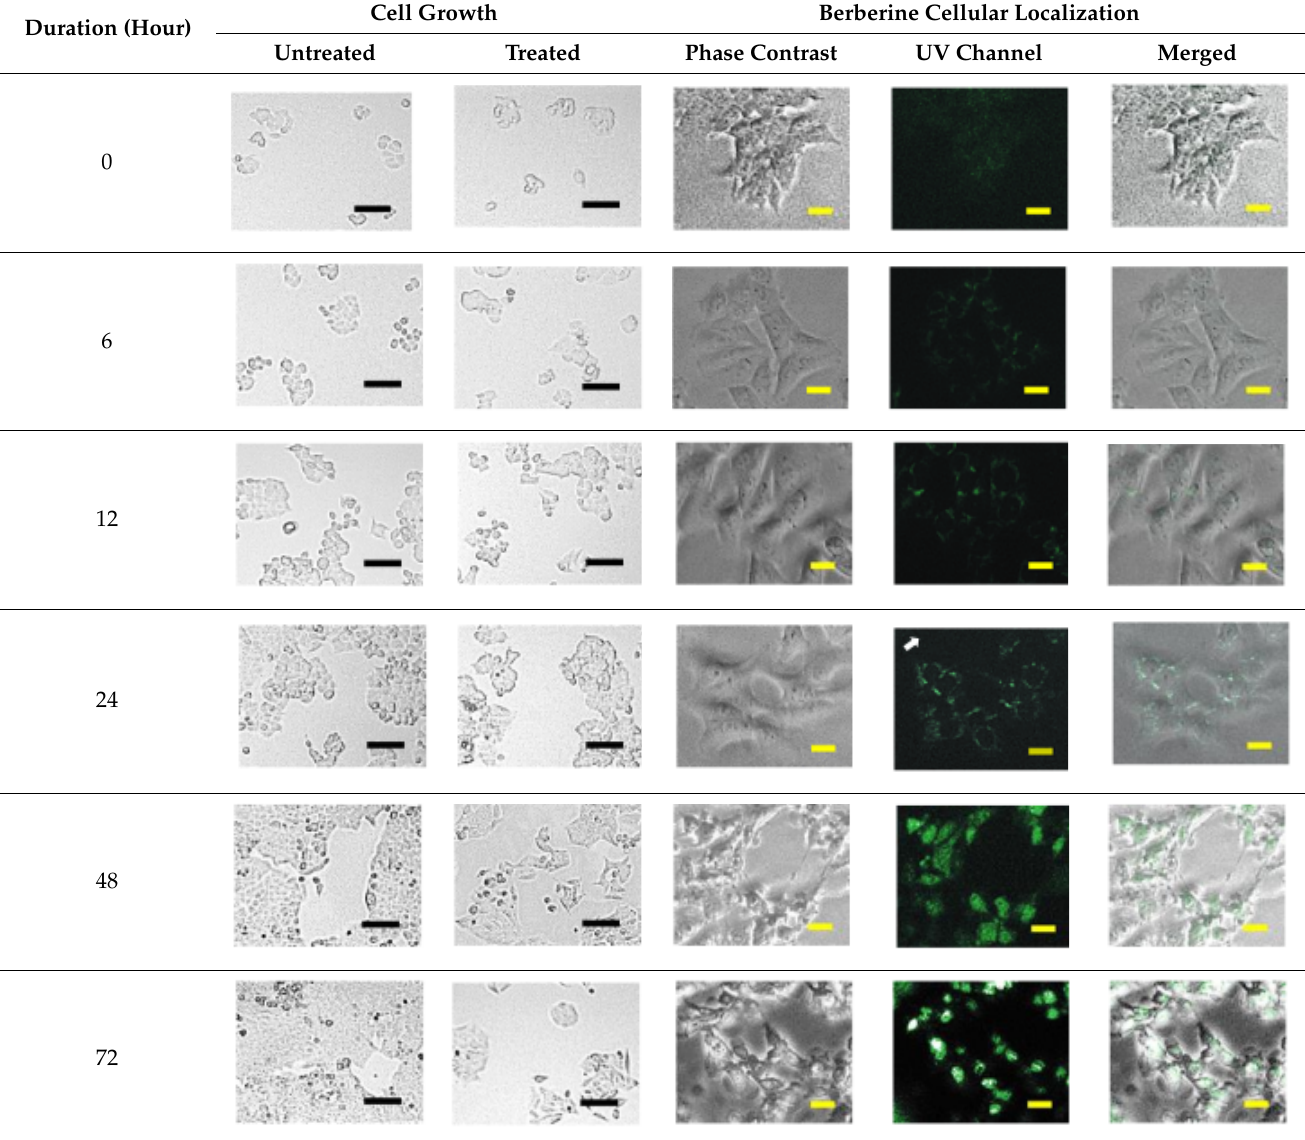
Table 2. Effect of 10.54 µ g/mL berberine treatment on HCT 116 growth at different durations. Berberine emitted green fluorescence under the ultraviolet (UV) channel of an inverted microscope. White arrows indicate nuclei appeared as